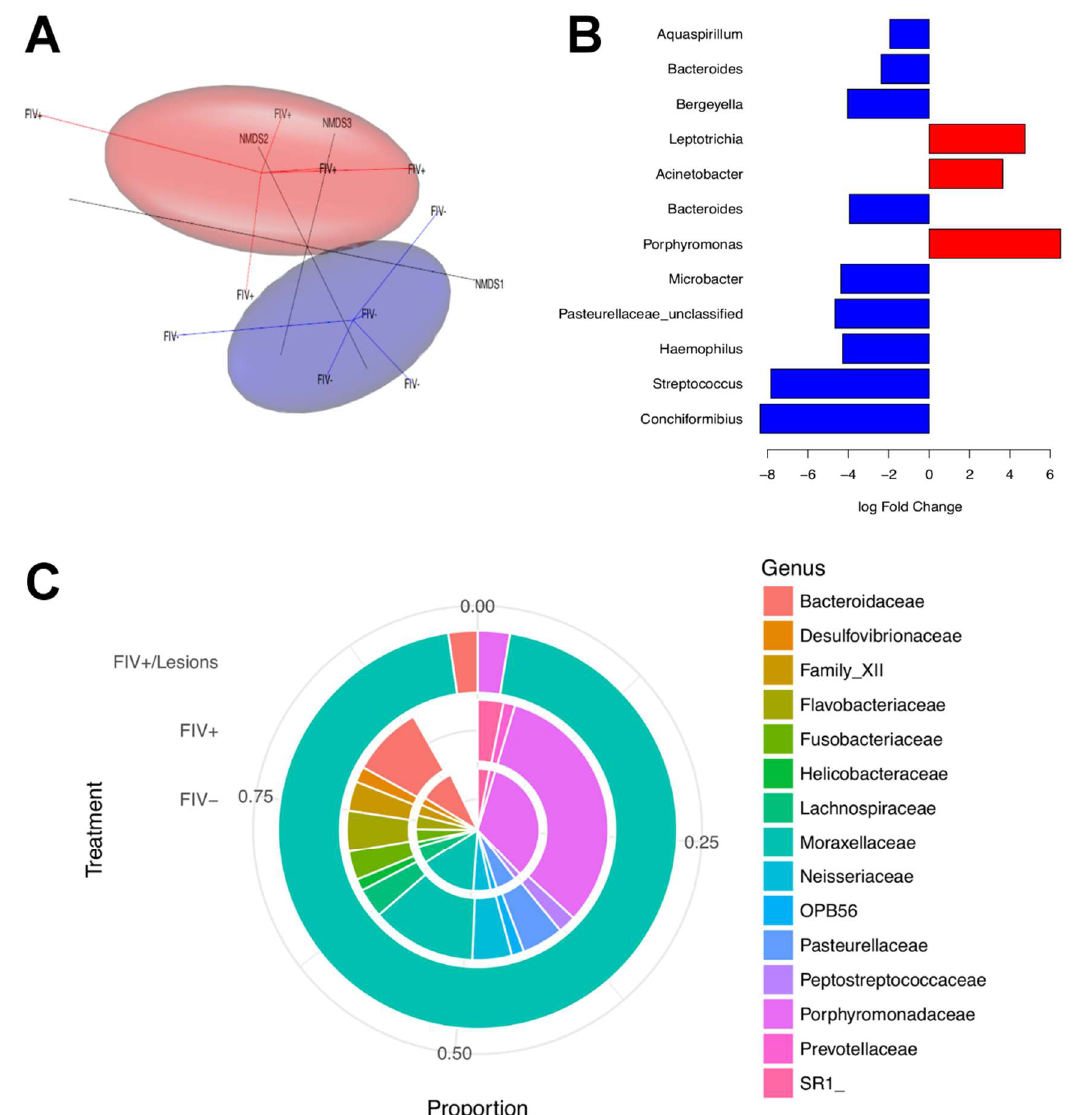
Figure 4. Salivary microbiome alterations during FIV infection. ( A ) Three-dimensional (3D) Nonmetric Multidimensional Scaling (NMDS) separates clusters of FIV− and FIV+ cat microbiome samples . Ovals represent the 90% confidence ellipsoids around the centroid of the clusters (FIV+ = red; FIV− = blue). ( B ) Operational taxonomic units (OTUs) with significant log-fold change in abundance between FIV+ and FIV− cats at the 0.1 level of significance (after correcting for multiple testing). The list on the left shows the genera of each of these OTUs. Red indicates over representation of that OTU in the FIV+ cats. ( C ) FIV+ cat with clinical gingivitis/periodontitis with near monoculture of Moraxellaceae (outer circle) as compared to the mean microbial community structure of cats that are FIV + (middle circle) and cats that are FIV negative (inner circle).